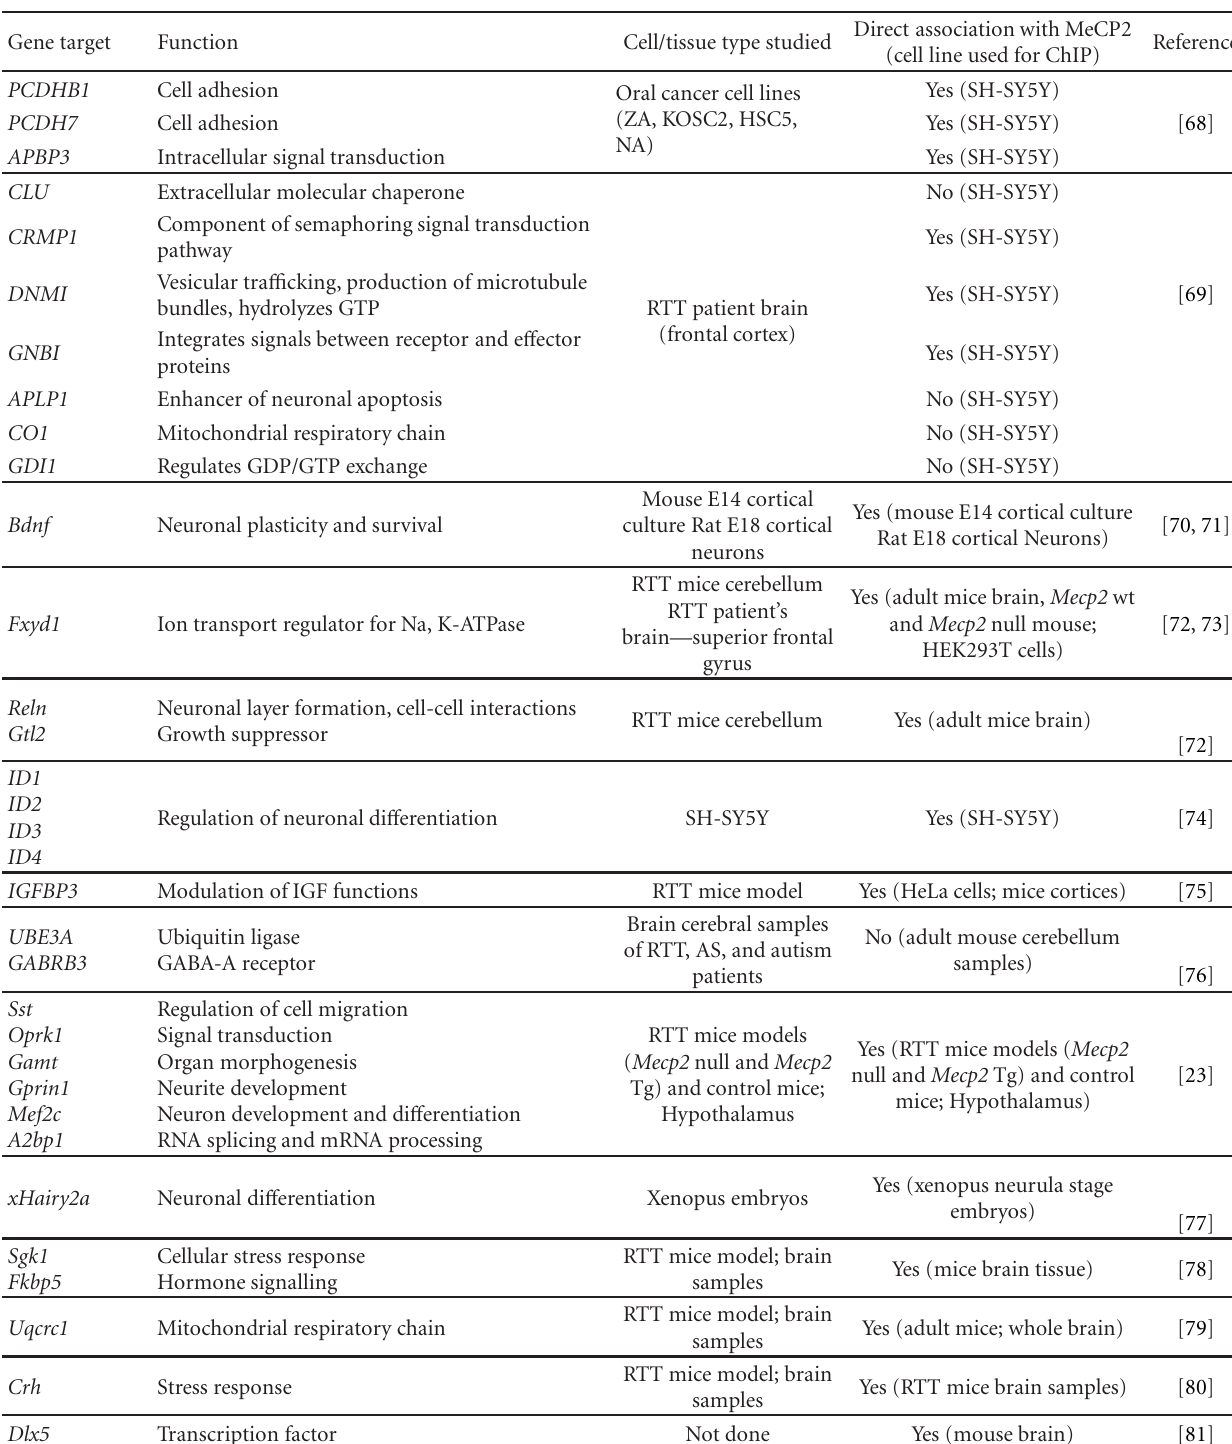
Table 1: Known targets of